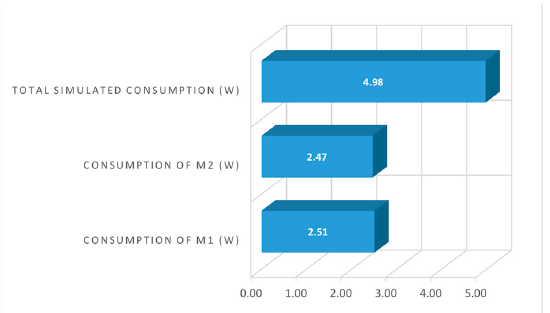
and measured current and power balance are presented in Table 13. The simulated power is estimated with an error of 29.5%.